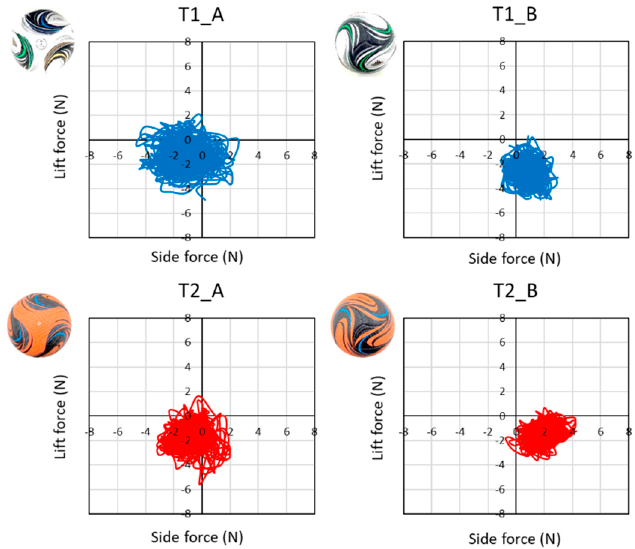
Figure 6. Scatter diagrams of changes in the lift and side forces acting on the balls in the wind tunnel test. Table 1. Mean and standard deviation of the lift and side forces on the soccer balls used in this experiment (10 s at wind velocity of 25 m/s).